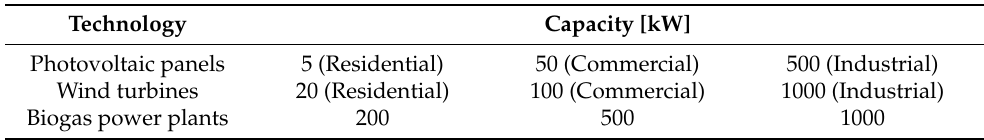
Table 1. Rated power of RES